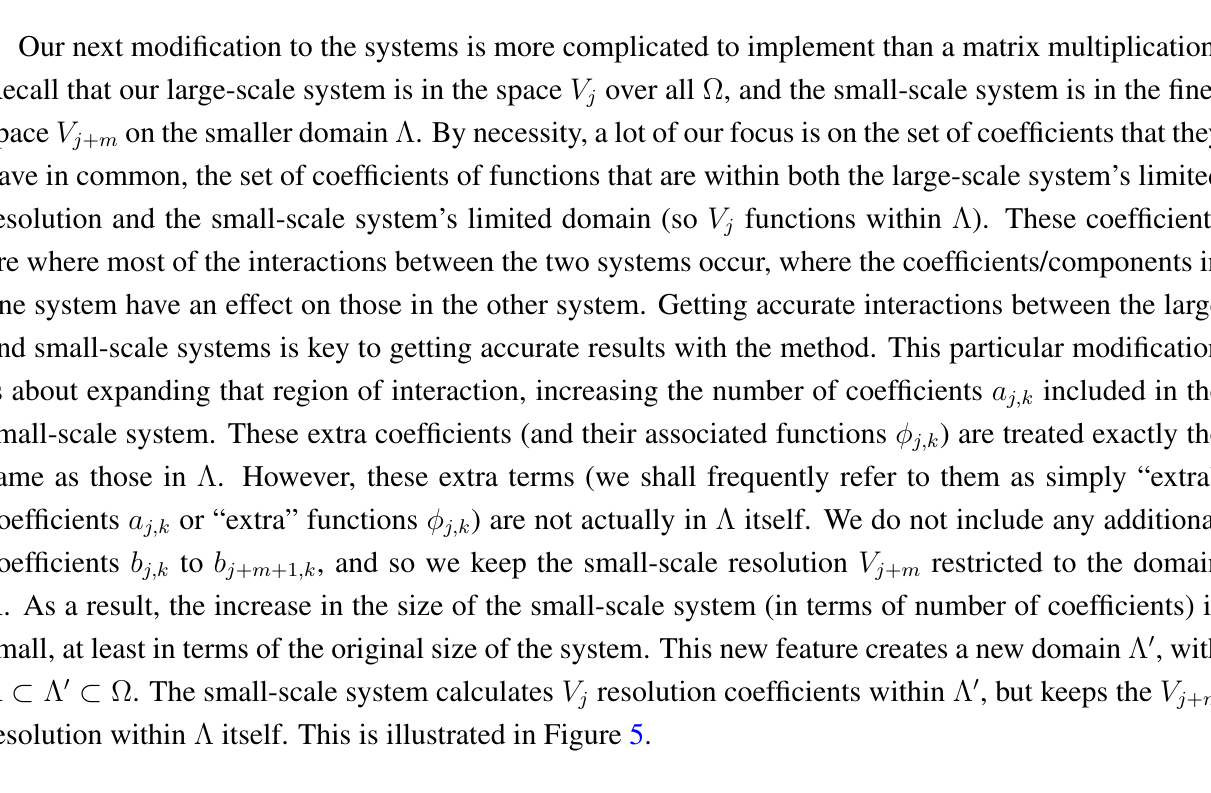
Figure 5. A simple diagram showing Ω , Λ , Λ ′ and the location of the “extra”